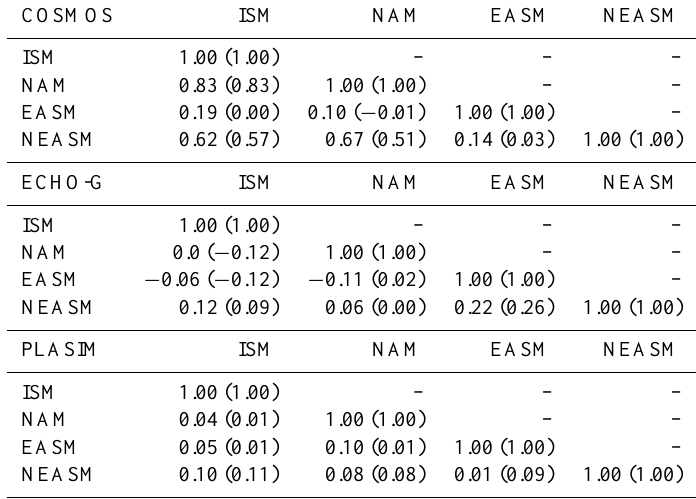
Table 3. Pearson correlation coefficients for the 0k rainfall time series, based on the last 150 years (1000 years) detrended by a 30-year (500-year) running mean for annual (decadal) variability, for different monsoon sub-regions, i.e. the Indian monsoon region (ISM), North African monsoon region (NAM), East Asian monsoon region (EASM), and the northern part of the East Asian monsoon region (NEASM). Only the non-accelerated simulations have been used.